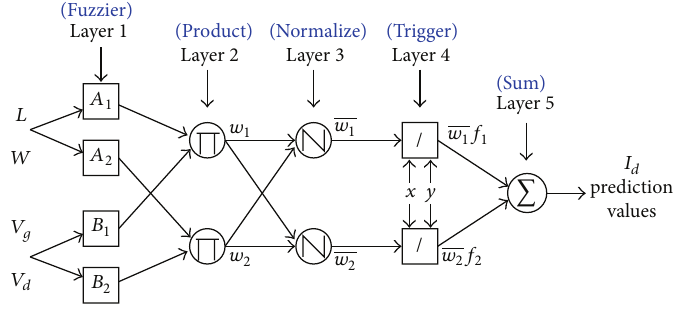
Figure 2: Predicting flow chart of 𝐼 𝑑 values in the ANFIS.